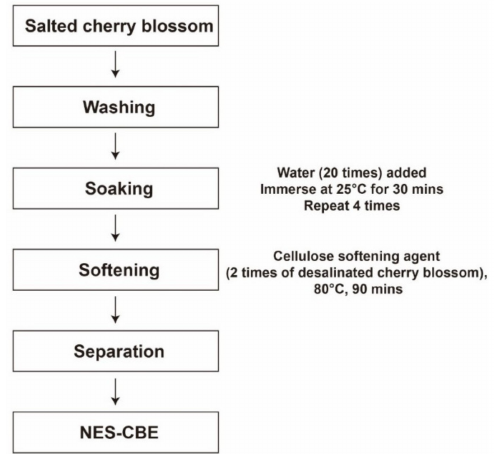
Figure 1. NES-CBE extraction process from salted cherry blossom using desalination and softening